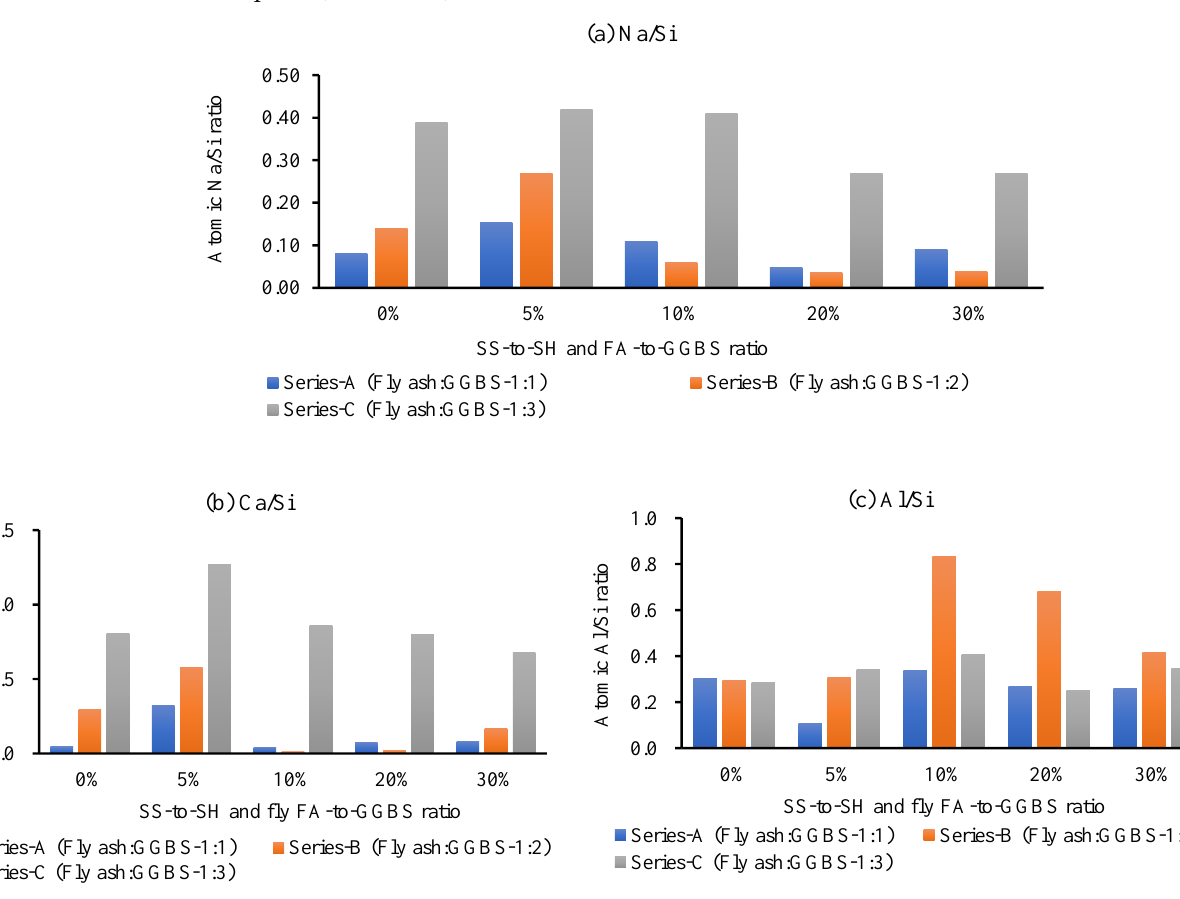
Figure 17. Elemental ratios obtained from the EDS analysis of the GPM mixes: ( a ) atomic Na/Si ratio; ( b ) Ca/Si ratio; ( c ) Al/Si ratio using various Na 2 SiO 3 -to-NaOH and FA-to-GGBS ratios with sand preheated at 110 ◦ C and cured in a hot oven at a constant temperature of 50 ◦ C for 3 h and 1 d room-temperature curing.